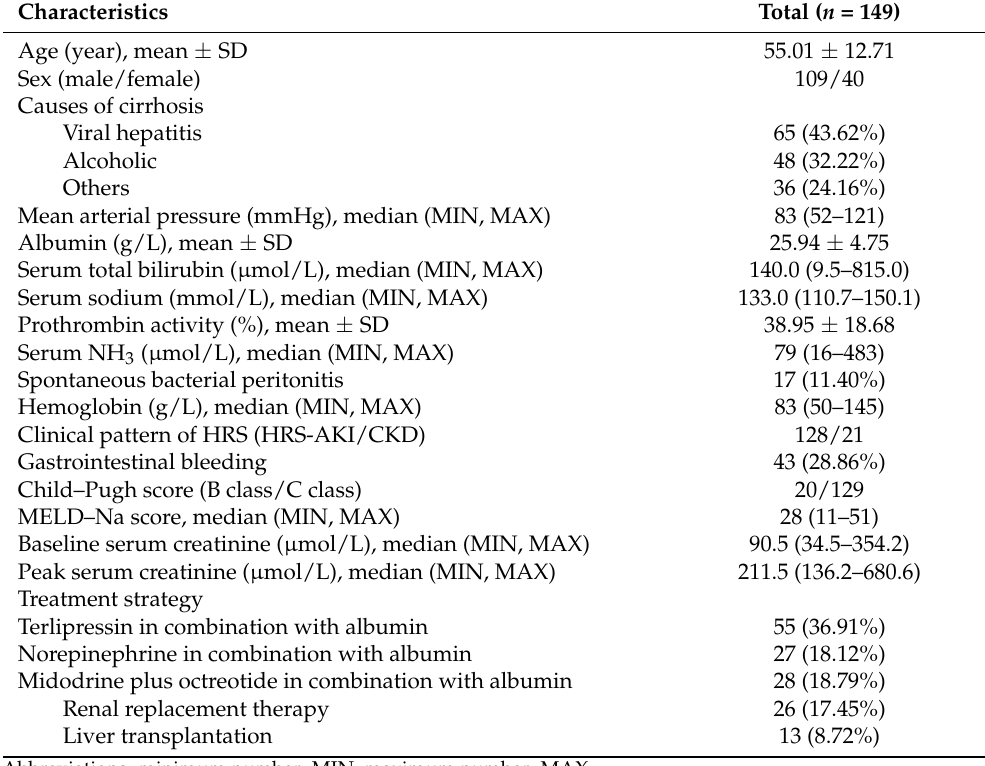
Table 1. Summary of demographics and clinical characteristics of patients with